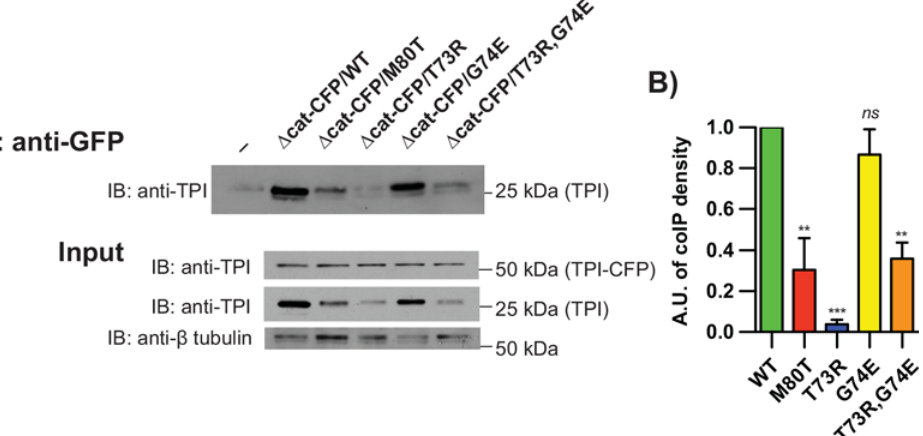
Fig 6. Heterodimerization of inactive TPI and dimer interface mutations. (A) dTPI Δ cat-CFP interacts modestly with dTPI M80T , dTPI T73R , and dTPI T73R,G74E , yet robustly with dTPI G74E . Representative immunoprecipitation and input blots are shown with (B) IP:anti-GFP quantification n = 3. Quantification represents 25kD TPI IP signal, with negative control subtracted, normalized to the lysate β -tubulin loading control, and compared to WT. Comparisons were made with a One-way ANOVA using Tukey ’ s post hoc test, ns indicates no significance, ** p < 0.01, and *** p <